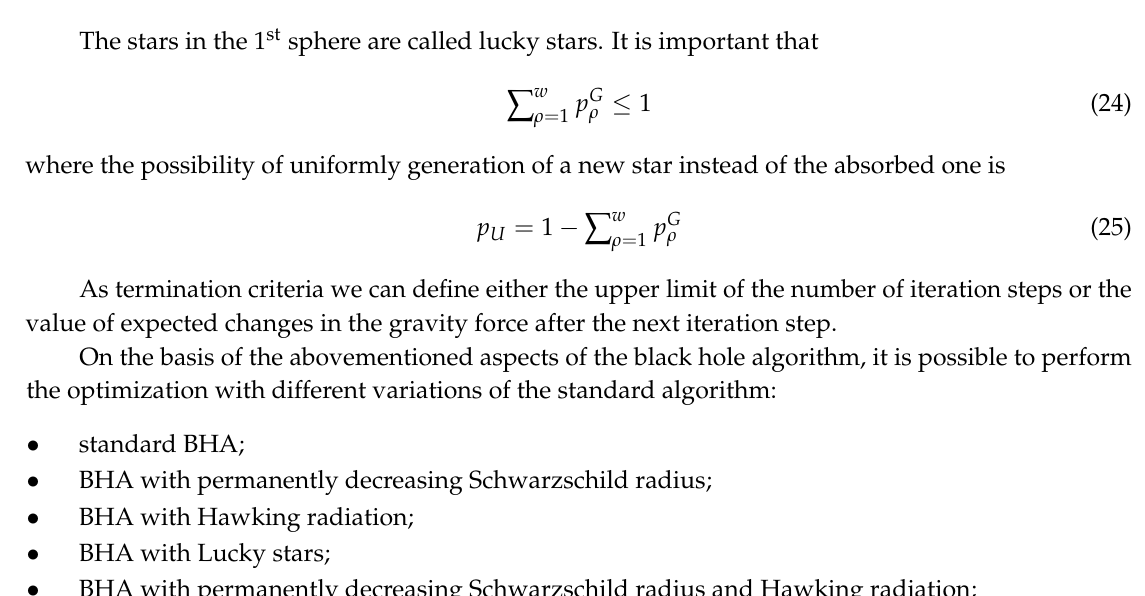
Figure 10. After each absorption, a new star is generated around the black hole. The different zones outside the event horizon are represented with different probabilities for the appearance of a new star.